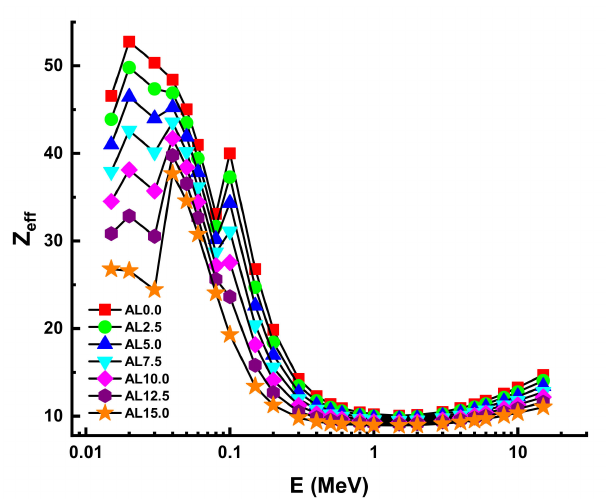
Figure 9. Variation of effective atomic number (Z eff ) against photon energy for all